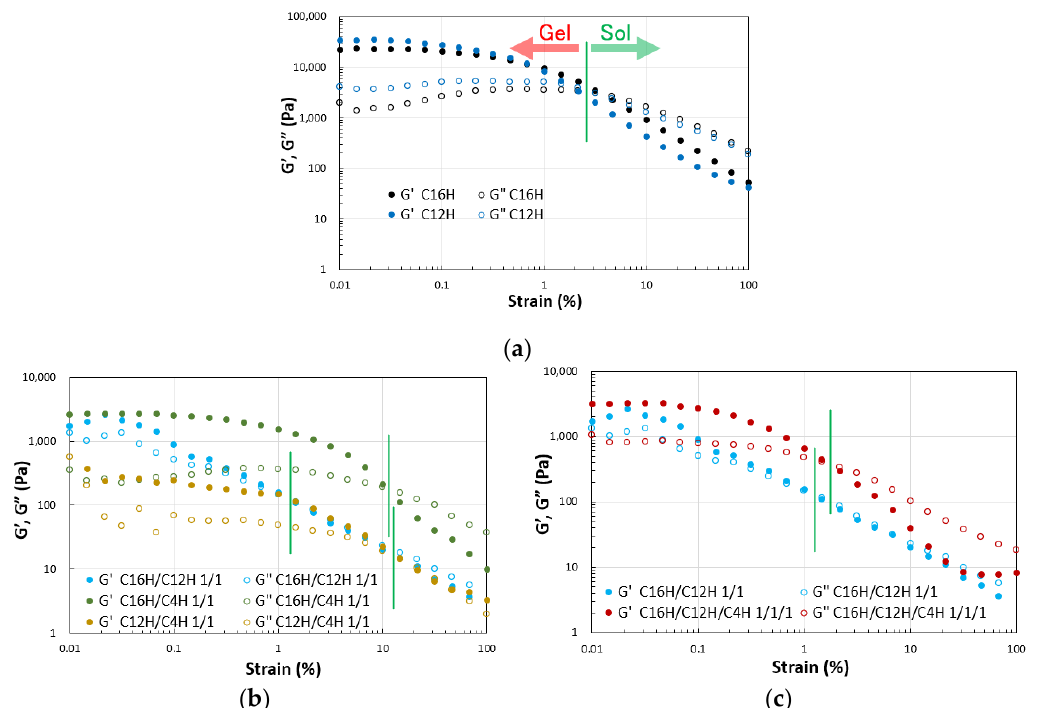
Figure 3. Dynamic rheological properties of the mixed molecular squalane organogels (3.0 wt.%) on strain sweep; ( a ) single gels, ( b ) binary gels, and ( c ) tertiary gels with C16H/C12H 1/1 gel as a reference.